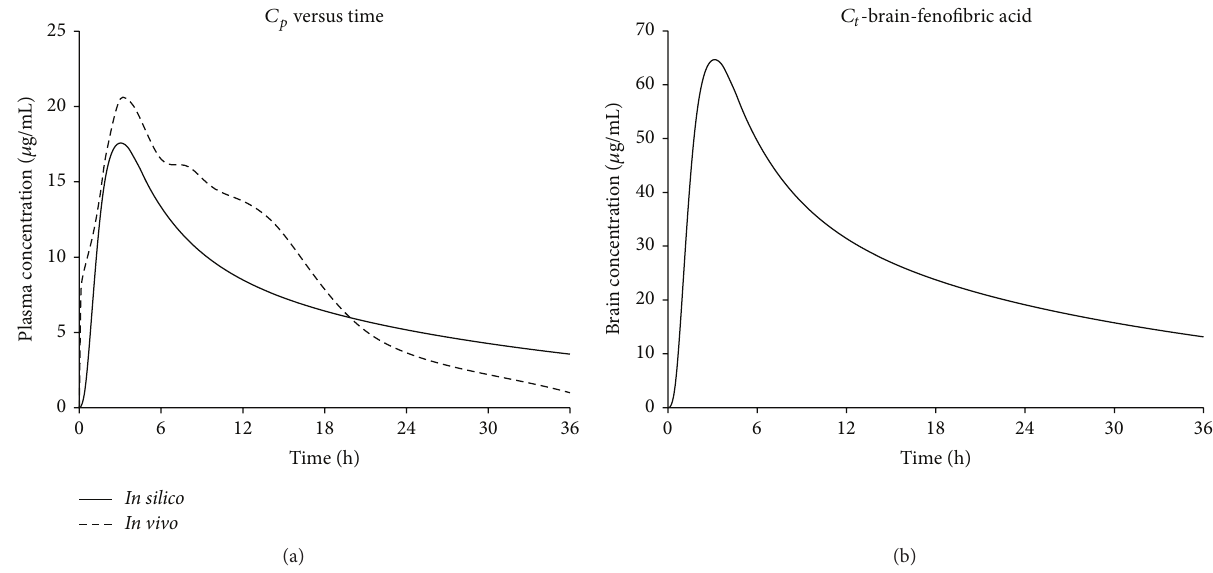
Figure 5: (a) Simulated and observed fenofibric acid plasma concentration profiles for micronize suspension at dose strength of 27 mg/kg in the fasted state. (b) The concentration profile of fenofibric acid in the